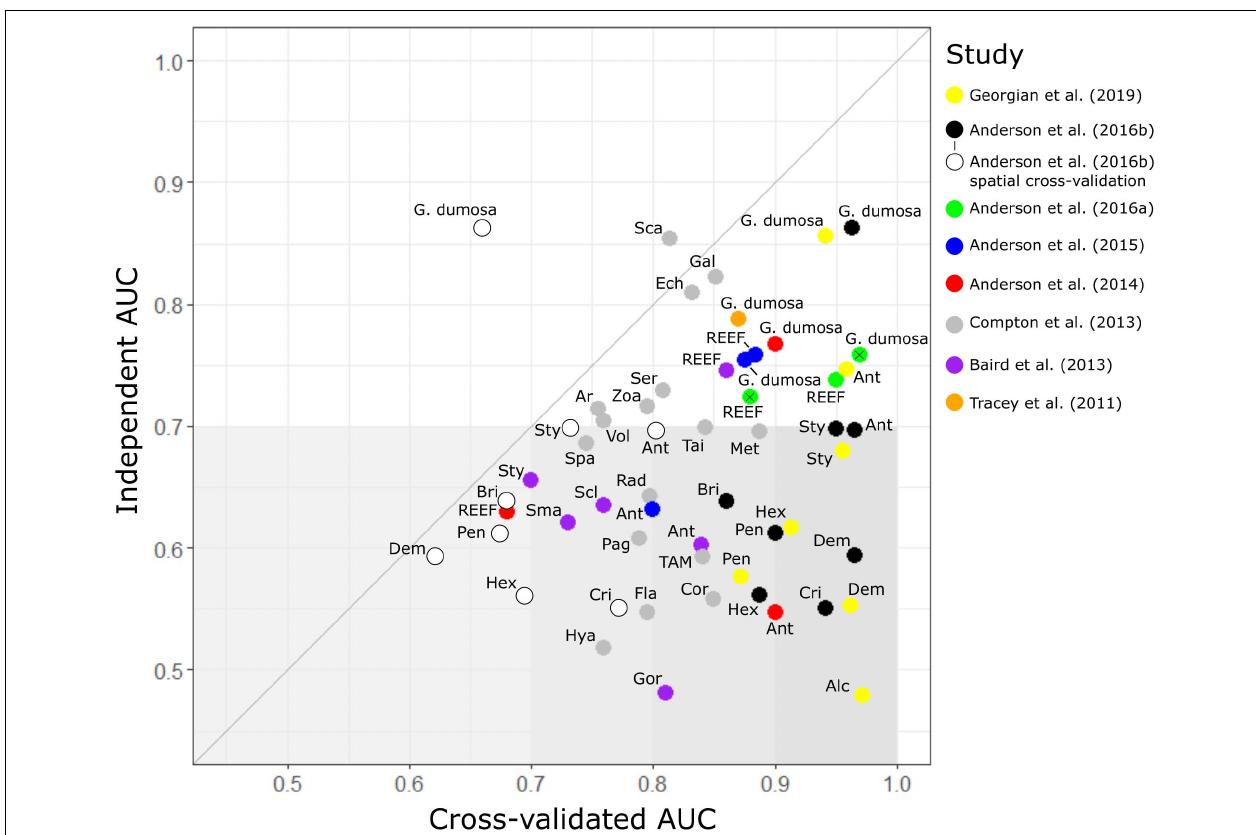
FIGURE 3 | Model assessment. Comparison of benthic invertebrate species-distribution model performance (as area under the receiver operator curve, AUC) when assessed against sample data withheld from the original dataset used to build the models (internal AUC) and an independent dataset of faunal distributions derived from photographic surveys (independent AUC). The 48 models are from eight published studies (see text for details) and cover 29 taxa: Alcyonacea (Alc); Anthomastus robustus (Ar); Antipatharia (Ant); Brisingidae (Bri); coral reef-forming taxa (REEF); Corallimorpharia (Cor); Crinoidea (Cri); Demospongiae (Dem); Gracilechinus multidentatus (Ech); Echinothuroida (TAM); Flabellum spp. (Fla); Galatheidae (Gal); Goniocorella dumosa ; Hexactinellida (Hex); Gorgonacea (Gor); Hexactinellida (Hex); Hyalinoecia tubicola (Hya); Metanephrops challengeri (Met); Paguridae (Pag); Pennatulacea (Pen); Radicipes spp. (Rad); Scaphopoda (Sca); Scleractinia (Scl); Serolidae (Ser); small solitary corals (Sma); Spatangidae (Spa); Stylasteridae (Sty); Taiaroa tauhou (Tai); Volutidae (Vol), and Zoanthidae (Zoa). Anderson et al. (2016a) modeled REEF and G. dumosa with BRT and MaxEnt separately; MaxEnt results are indicated with a cross. Anderson et al. (2016b) calculated AUC in two ways: random selection of sites (black plots) and in longitudinal bands (white plots). Gray line shows a 1:1 relationship between internal and independent AUC scores, and gray shading indicates independent AUC scores less than 0.7, a value above which models are considered to be potentially useful for prediction, with darker shading to highlight the largest discrepancies between internal and independent AUC